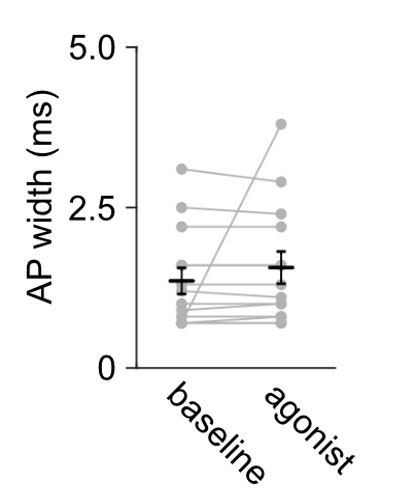
Action potential widths remain stable during cell-attached recording and they are comparable to other studies in the L5 pyramidal neurons on the cortex.Summary data of median full width at half-maximum of action potential currents recorded in L5 pyramidal neurons of the ACC; n = 14 neurons from 5 mice. The agonists (DAMGO or DPDPE) did not change the recorded action potential current width; Mann-Whitney U test U = 189, p = 0.5320.